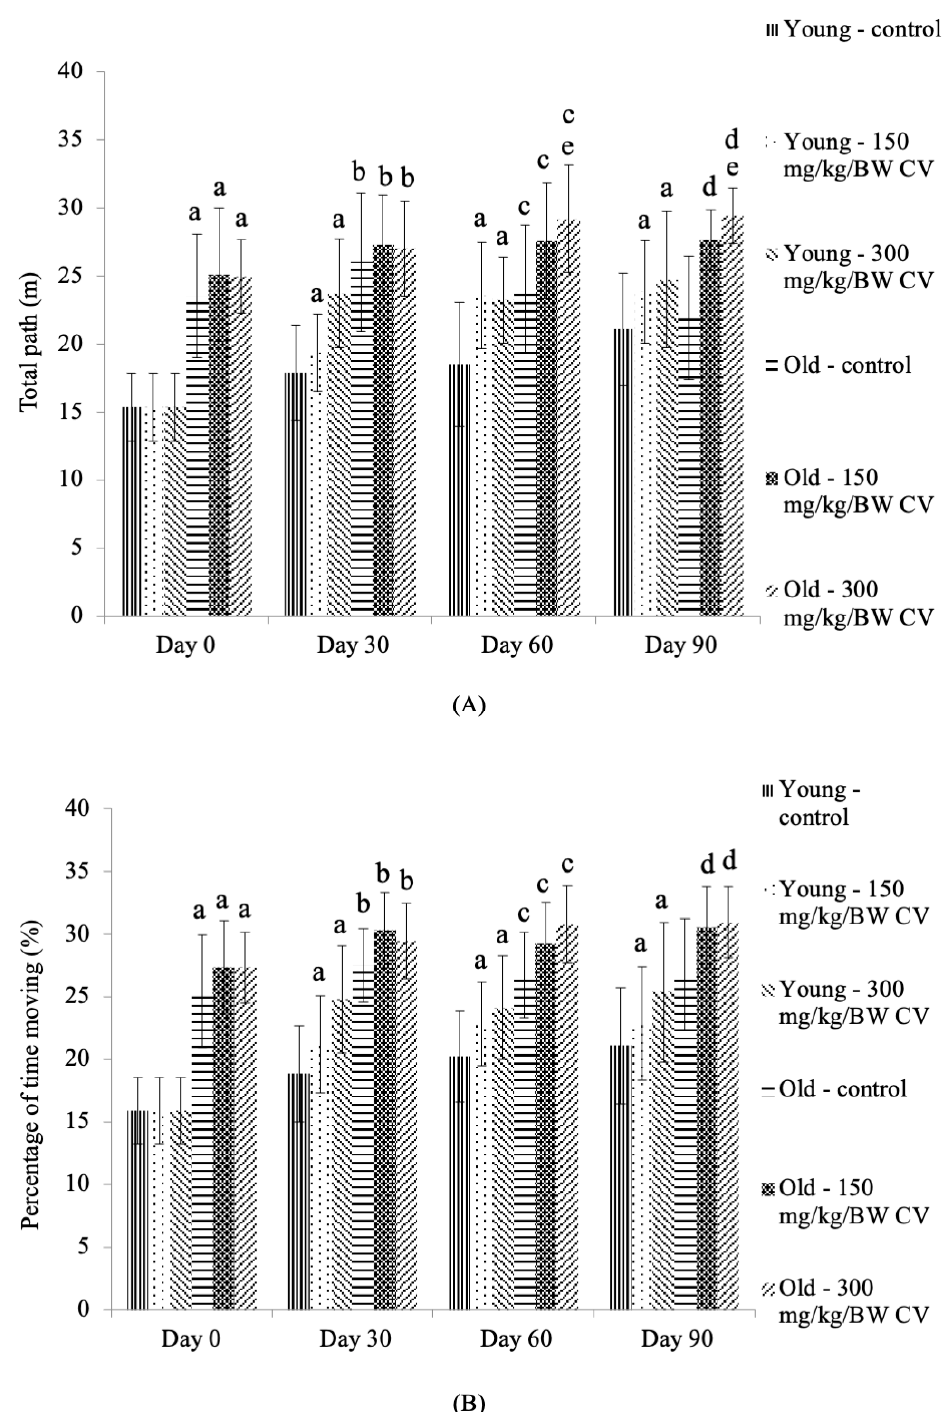
Figure 4. The ( A ) total path and ( B ) the percentage of time spent moving by the young and old rats. The data are presented as the mean ± SD, n = 8 (control rats), n = 10 ( C. vulgaris -treated rats). a p < 0.05 significantly di ff erent compared to the control young rats on Day 0, b p < 0.05 significantly di ff erent compared to the control young rats on Day 30, c p < 0.05 significantly di ff erent compared to the control young rats on Day 60, d p < 0.05 significantly di ff erent compared to the control young rats on Day 90, e p < 0.05 significantly di ff erent compared to the control old rats on Day 0, with a post hoc Tukey HSD test. BW: Body weight; CV: C.